Question: Judging by this figure, is the value going up or going down?
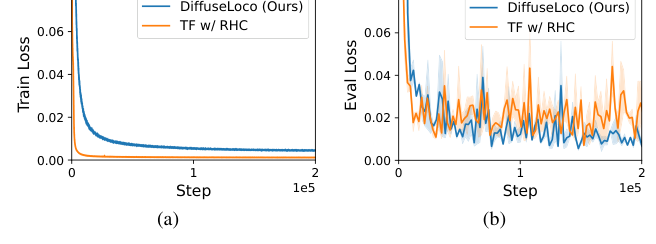
Answer: increasing